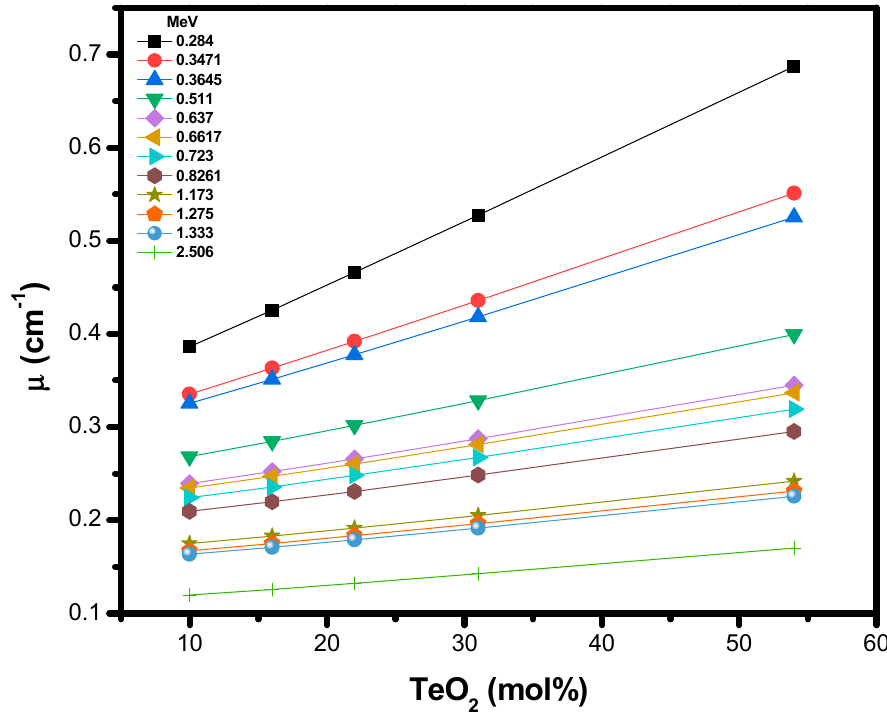
Figure 3. The linear attenuation coefficient (cm − 1 ) for the TeBYbX glasses. Figure 4 graphs the transmission factor, or TF, of the TeBYb1 sample at five different thicknesses against energy. A smaller TF signifies a more effective shielding material. This sample was chosen as an example to investigate the effects of thickness and photon energy on the TF of the glass. Five thicknesses were chosen, 0.3, 0.6, 0.9, 1.2, and 1.5 cm, to test